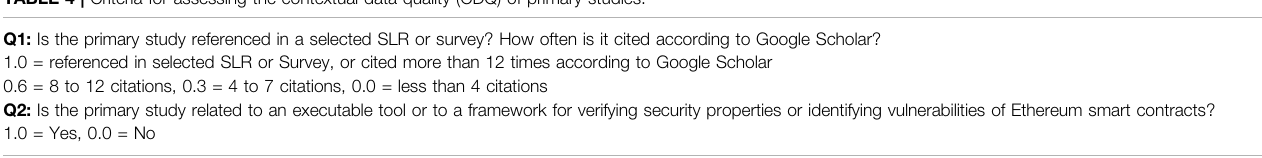
TABLE 4 | Criteria for assessing the contextual data quality (CDQ) of primary